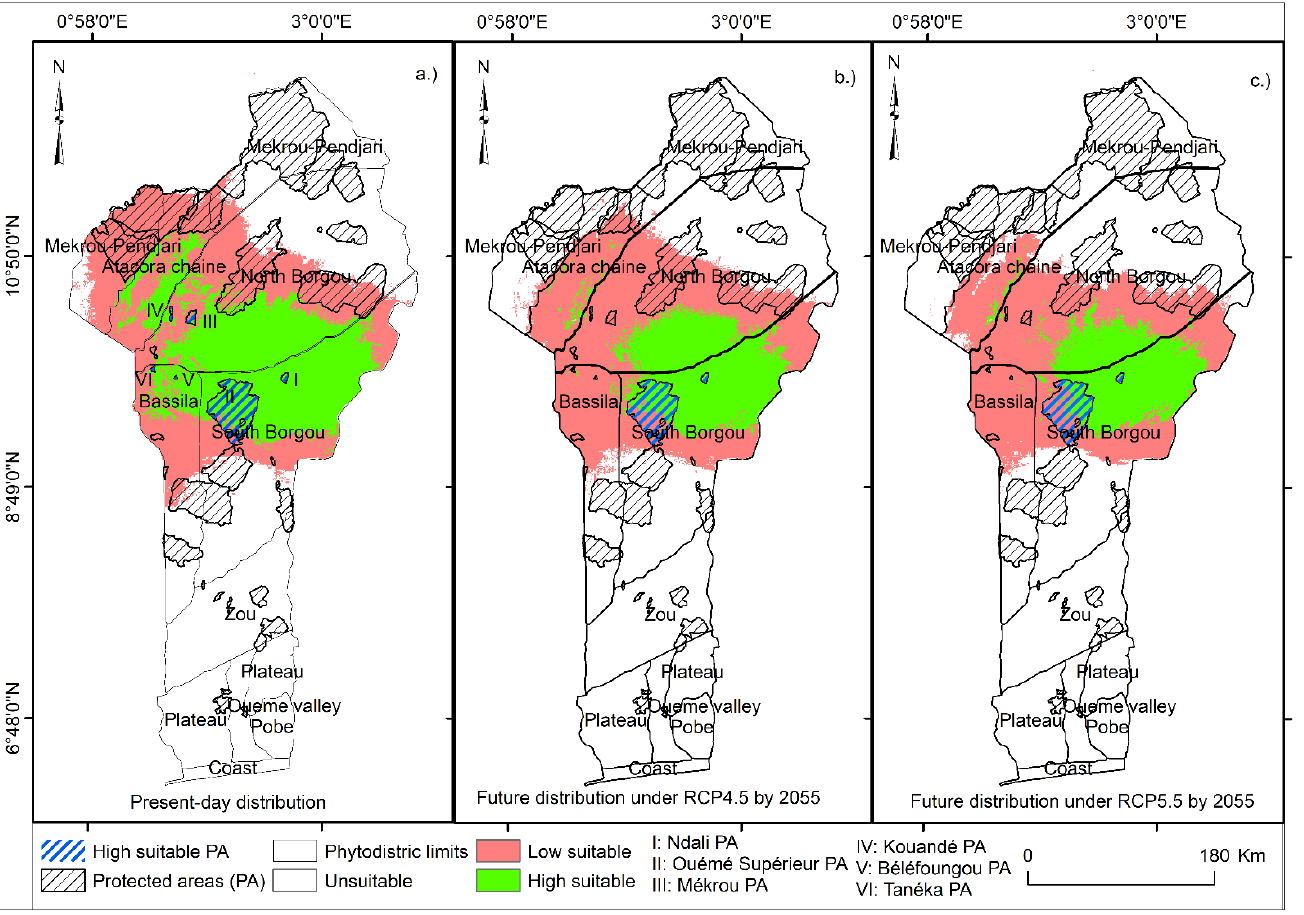
Figure 1. Distribution maps for of Ipomoea beninensis ; ( a ) present-day distribution; ( b ) future distribution under RCP 4.5; ( c ) future distribution under RCP 8.5.